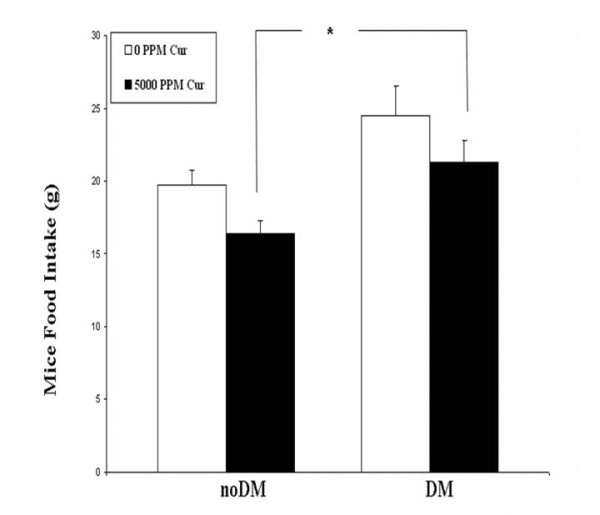
Mouse Food Intake. After Stz-injection and curcumin feeding began (Experiment 1), the total amount of control chow (0 ppm curcumin) or curcumin chow (5,000 ppm curcumin) consumed by each mouse over the preceding 4 days was measured on day 4. *P < 0.05.